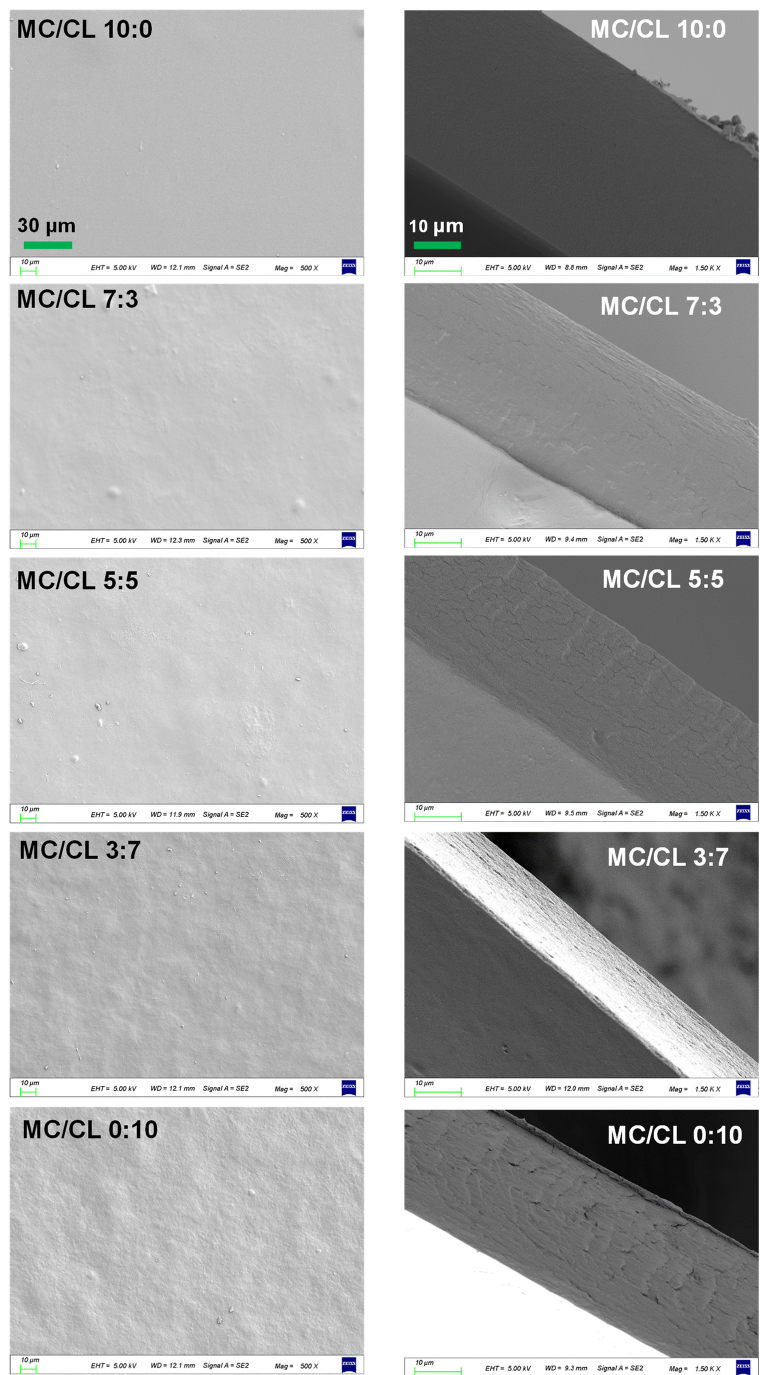
Figure 4. Surface and cross-sectional morphologies of the MC/CL films with different blend ratios. The same column uses the same scale bar.